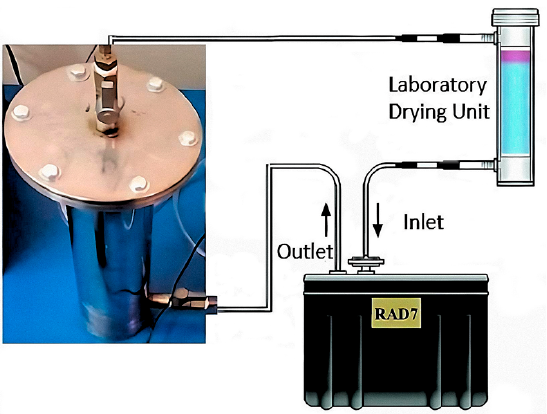
Figure 2. Experimental setup to assess 222 Rn exhalation rates from mine tailings samples using the